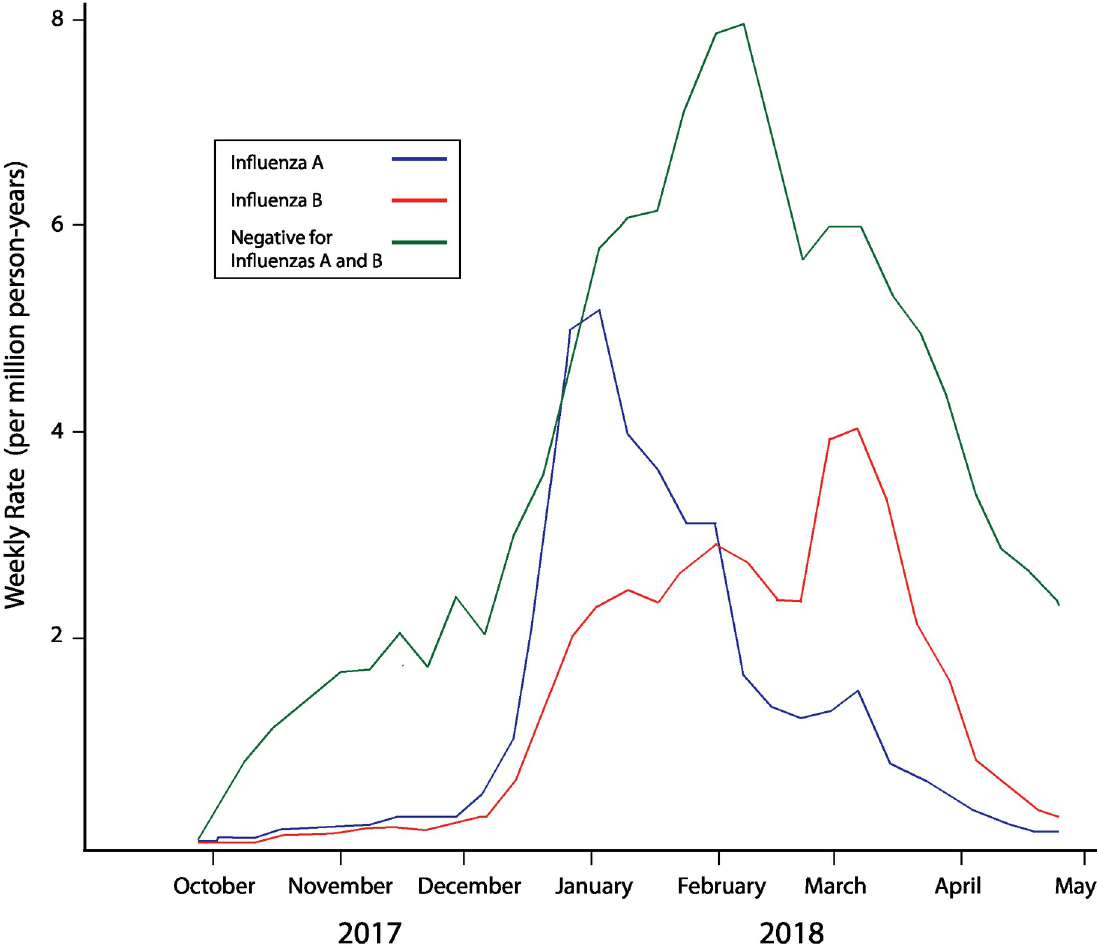
Fig 1. Rates of Influenza A and B in the Study Population by Week, Kaiser Permanente Northern California 2017–18. Blue line denotes weekly rate of influenza A (per million person-years per week), red line denotes weekly rate of influenza B (per million person- years per week), and green line denotes the weekly rate of negative influenza A and B tests (per million person years per week).